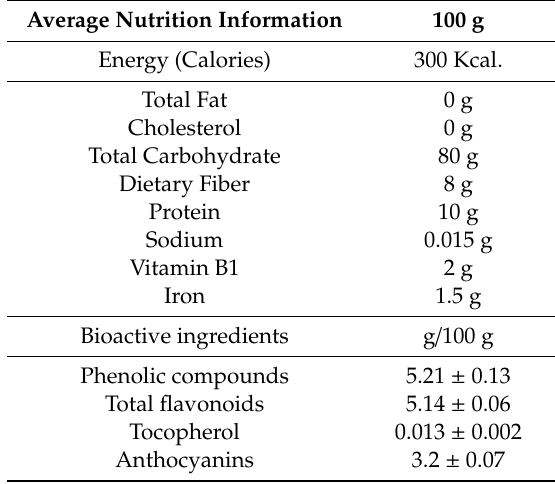
Table 1. Nutritional value information and bioactive ingredients of the black rice germ and bran